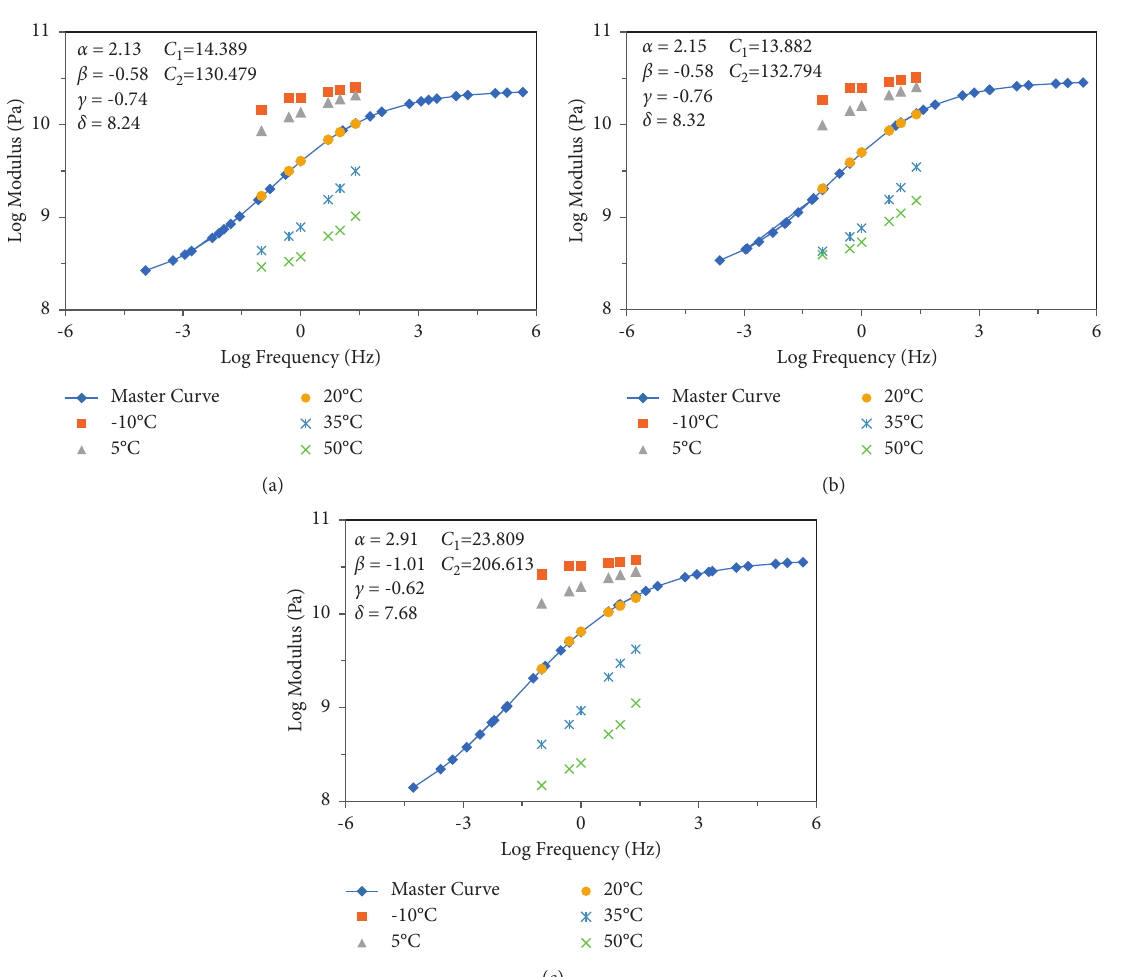
Figure 3: Dynamic modulus master curve and its fitting parameters: (a) AC-13, (b) AC-20, and (c) AC-25.